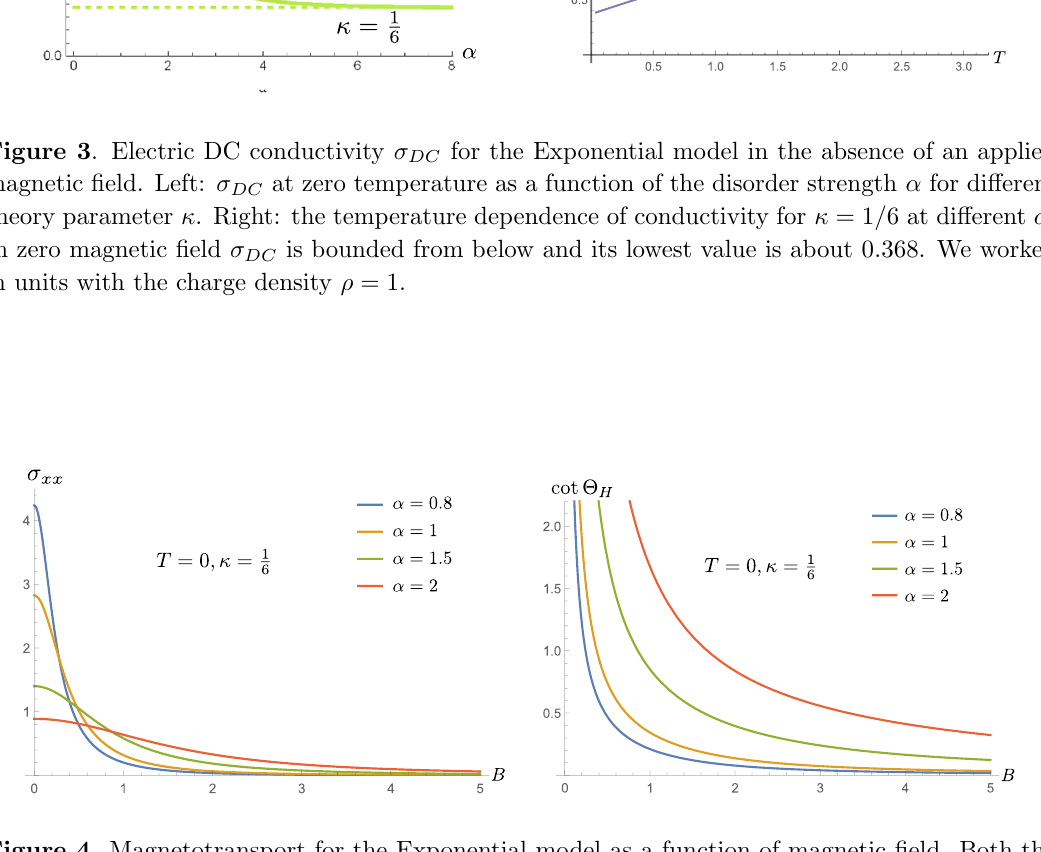
clearly, we consider the inverse Hall angle cot (cid:2) the relative magnitude of two conductivities. As one can see from the right plot of (cid:12)gure 4, the inverse Hall angle cot (cid:2)